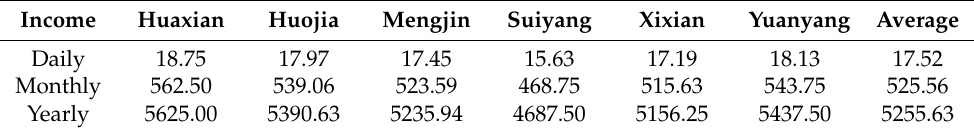
Table 5. Income from migrant workers in selected counties (unit: